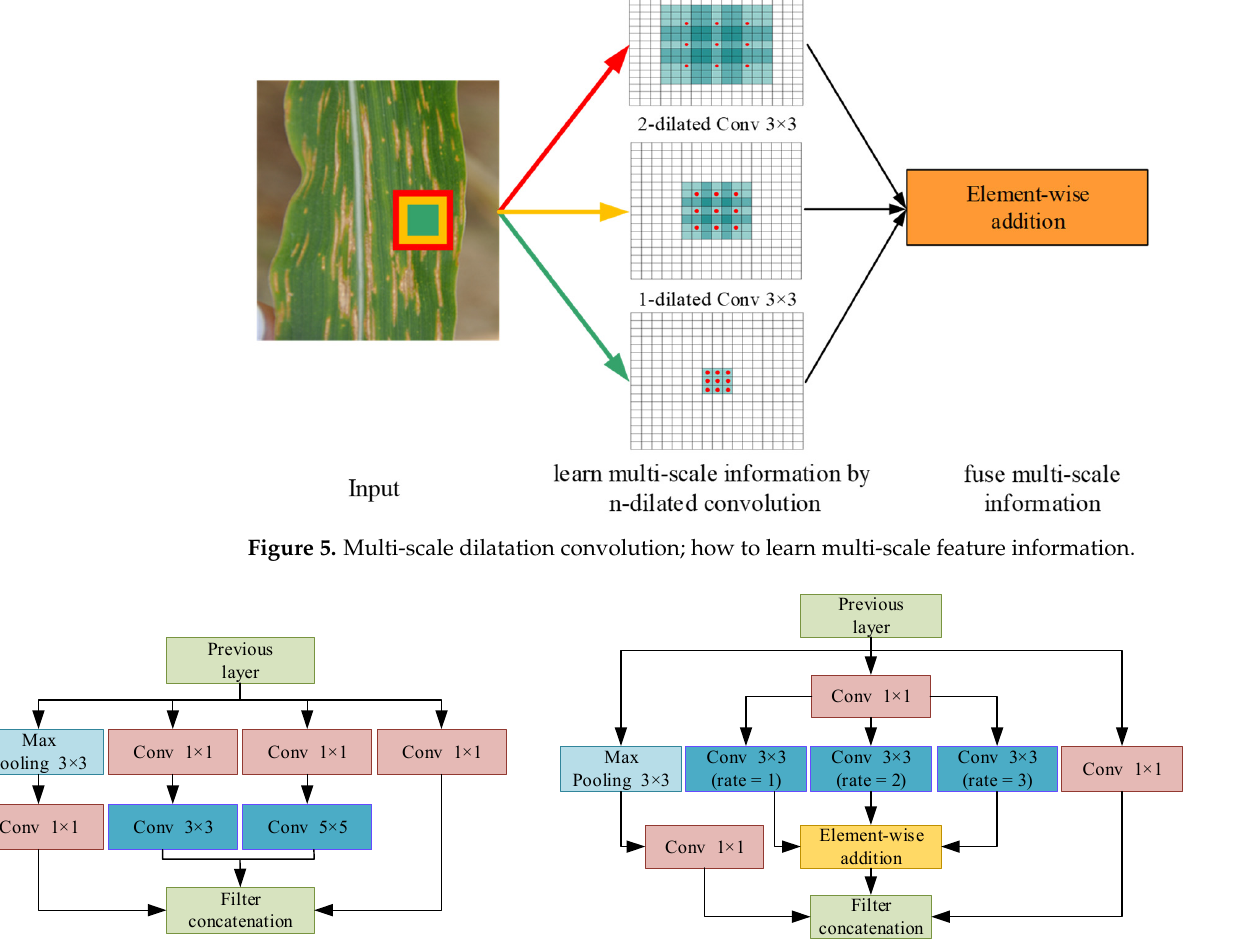
Figure 6. The inception module with its variations.